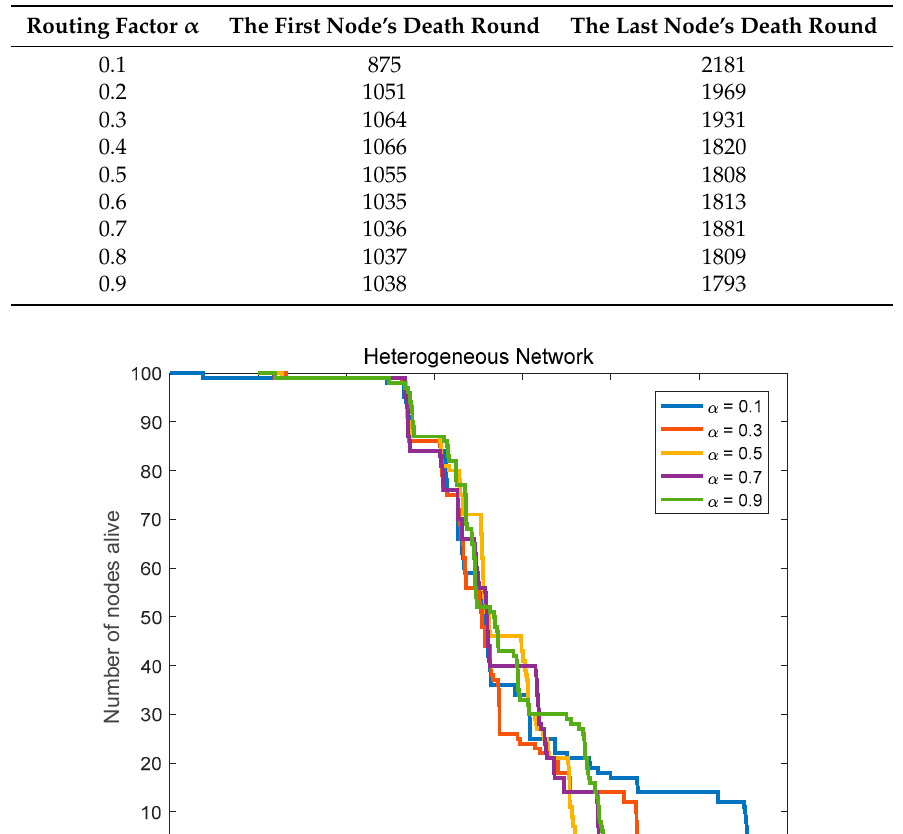
Figure 12. The network lifetime comparison in heterogeneous networks (routing factor = 0.2, 0.4, 0.6 and 0.8). 4.1.3. The Optimal Routing Factor Although the network has the longest lifetime in the case of α = 0.1 compared with other cases, its first node death time is too early, which means that the energy consumption distribution of the nodes is rather uneven in this case. In homogeneous networks, the first node’s death round in the case of α = 0.2 is 1018, it is too small. Although the first node’s death rounds in the case of α = 0.4–0.9 are very close, the last node’s death round in the case of α = 0.4 is the largest among them. The first node’s death round in the case of α = 0.3 is less than that in the case of α = 0.4, but the last node’s death round in the case of α = 0.3 is more than that in the case of α = 0.4. Thus, the optimal routing factor α in homogeneous networks is 0.3 or 0.4.